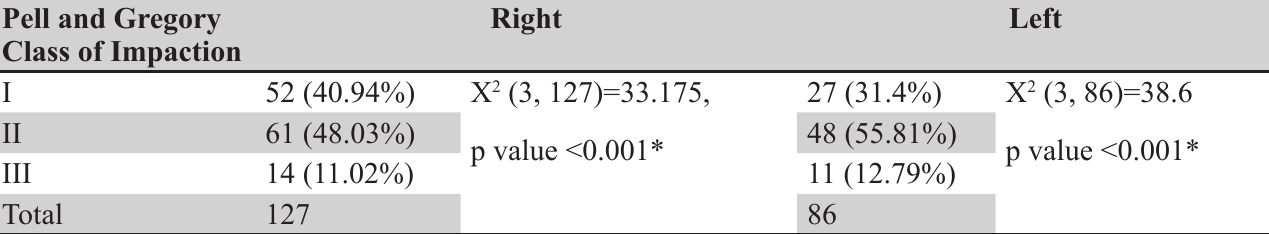
Table 5: Darkening of roots in respect to Pell and Gregory Class of Impaction of mandibular third molar. Pell and Gregory Class of